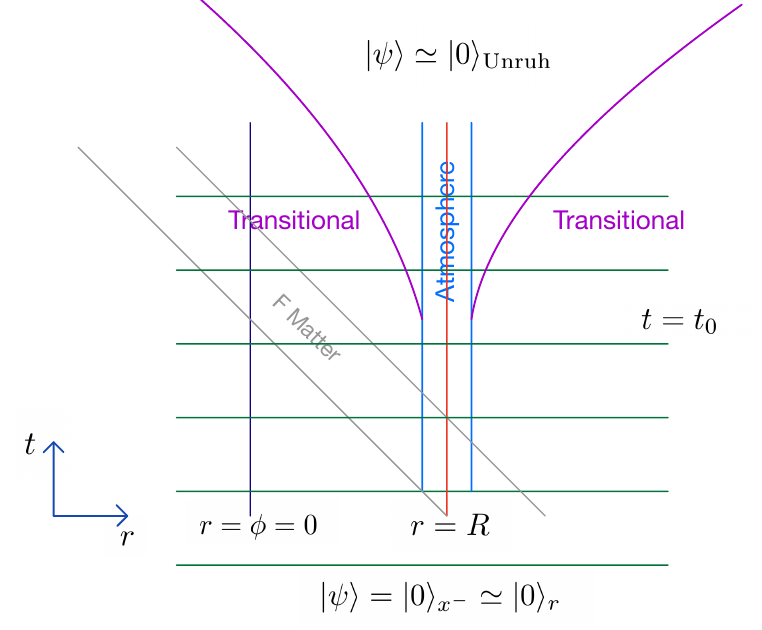
Figure 5 . A depiction of the evolving state in the background geometry induced by an incoming F -wave, which produces a BH. A straight time slicing is shown. In the region after the incoming wave turns off, the classical solution is static. The induced quantum state of the matter, with initial vacuum state, has a transitional region, resulting from the time-dependence of the collapse. This time-dependent radiation escapes to infinity or falls into the strong-coupling region, after which the state asymptotically settles down to a stationary state. This late-time state is approximated by the Unruh vacuum. The outgoing Hawking excitations, and their inside partners, can be thought of as produced in an atmosphere region | r − R | < ∼ 1